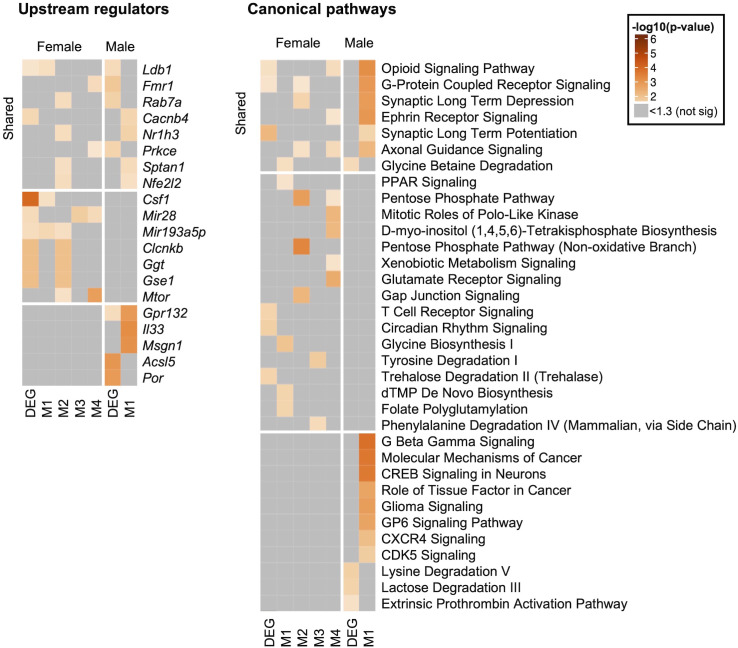
Top canonical pathways and potential upstream regulators of nPM associated genes in C57BL/6J mouse.